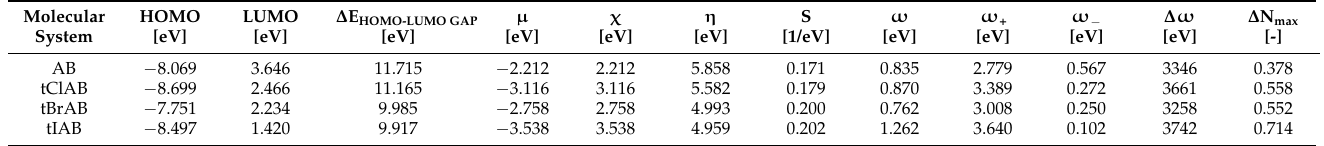
Table 9. A comparison of reactivity descriptors (the Highest Occupied Molecular Orbital, HOMO, Lowest Unoccupied Molecular Orbital, LUMO, HOMO-LUMO gap, ∆ E HOMO-LUMO GAP , chemical potential, µ , absolute electronegativity, χ , absolute hardness η , softness S, electrophilicity index, ω , the electron-accepting power, ω + , the electron-donating power, ω − , the net electrophilicity, ∆ ω , and the maximum amount of electronic charge, ∆ N max ) calculated at MP2